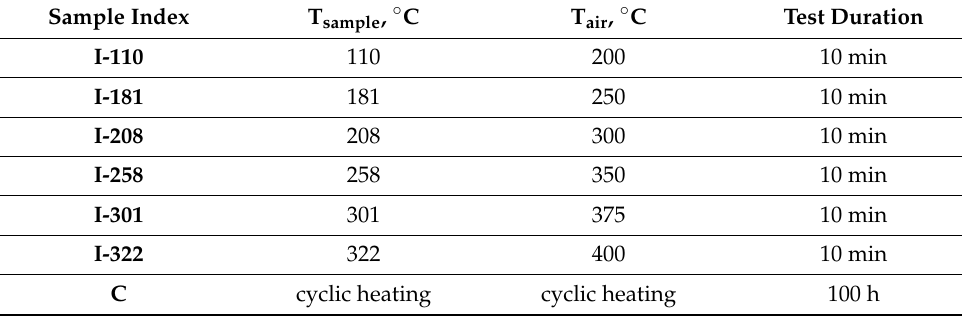
Table 2. Summary of deposit samples.